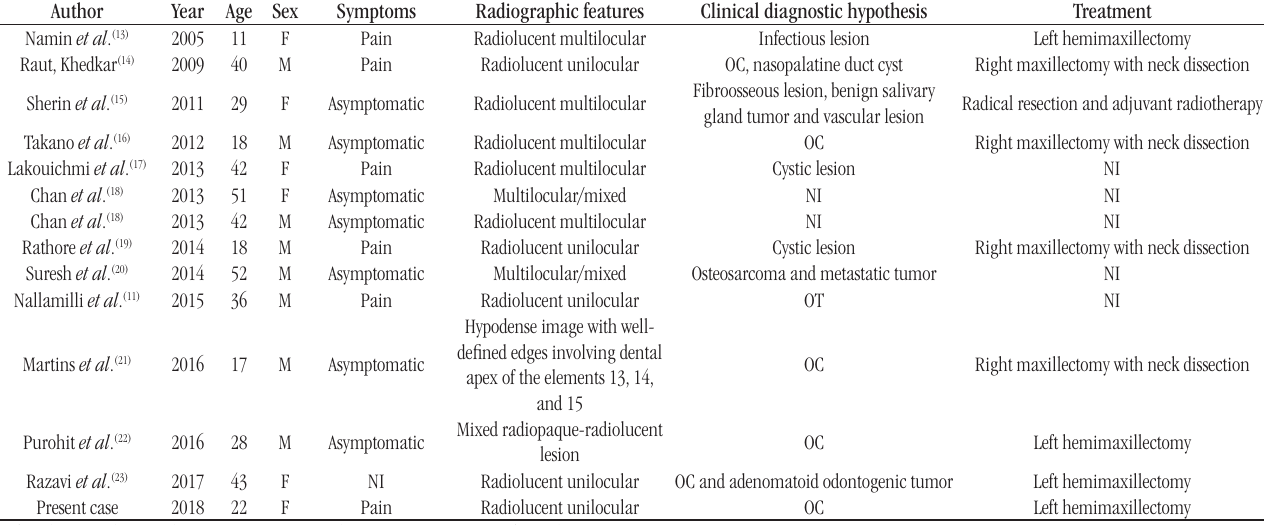
taBLE − Features of intraosseous mucoepidermoid carcinomas of the maxilla reported in the database PubMed/Medline (2005-2018)